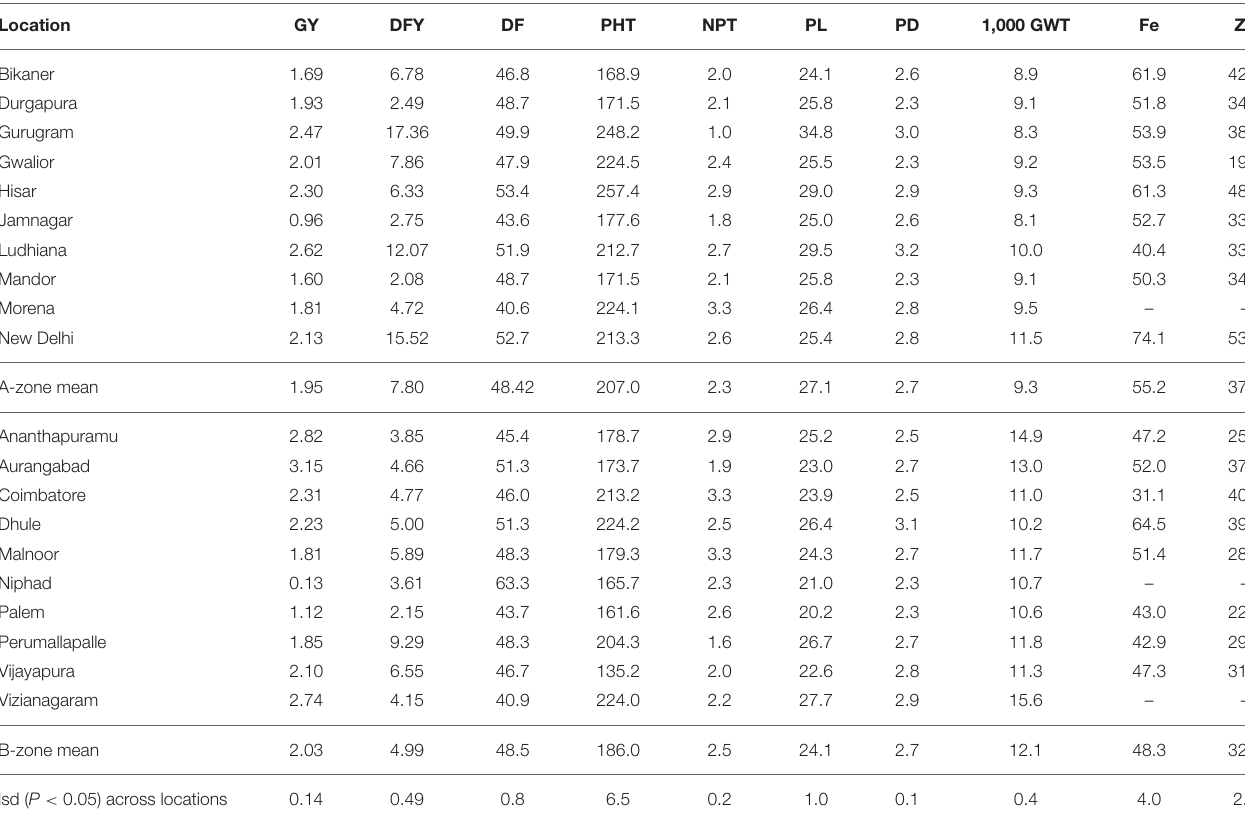
TABLE 5 | Location and zonal means for grain yield and quality traits pooled across OPVs. Location GY